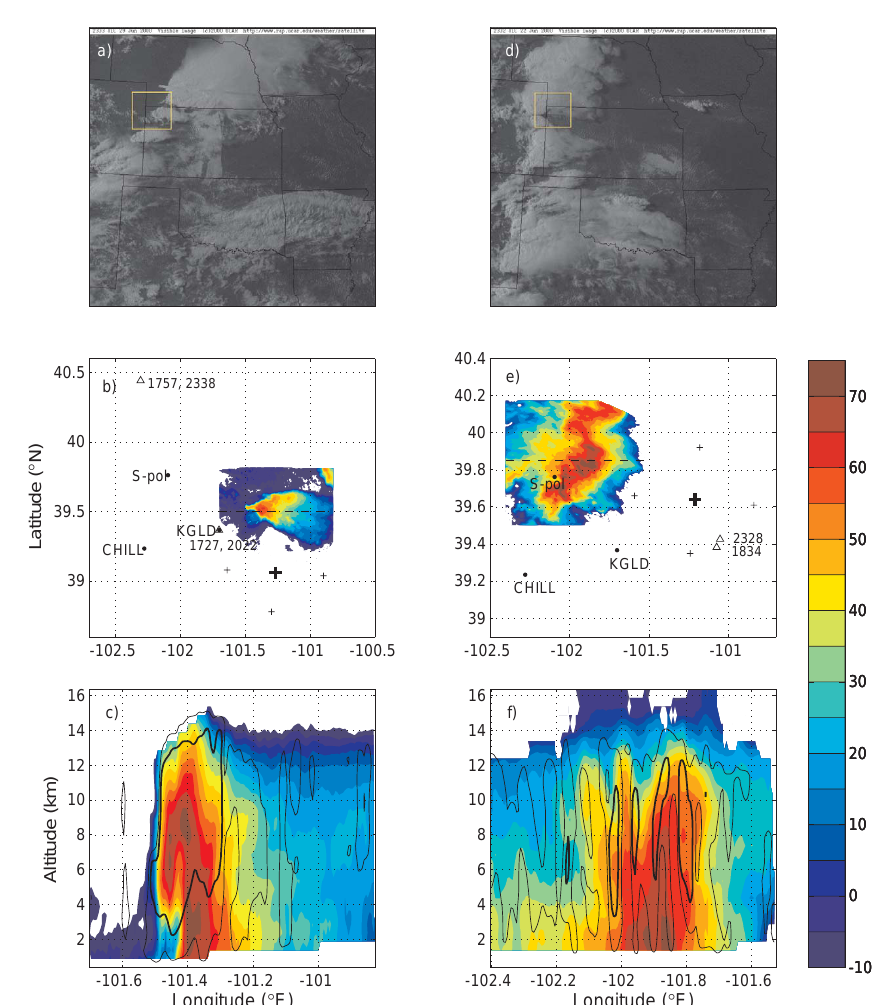
Fig. 1. Overview of the 29 June 2000 STEPS supercell case at time 23:57UTC (a–c) and the 22 June STEPS convective line case at time 00:48UTC (d–f) . Panels a and d show a visible satellite image of each case, with the dual-Doppler analysis area highlighted with a yellow square. Panels b and e show horizontal cross-sections of radar reflectivity (dBZ) at 2km height (a.g.l). Solid dots indicate radar locations, triangles indicate locations of mobile soundings (with launch times labeled), and plus marks show locations of NARR simulated soundings. The bolded plus mark indicates the “most representative” NARR sounding. (c) and (f) show vertical cross-sections of radar reflectivity (dBZ) at the locations indicated by a dashed horizontal line in (b) and (e) . Contours of vertical velocity of 1ms − 1 and 10 ms − 1 are overlain (thin and thick black lines,